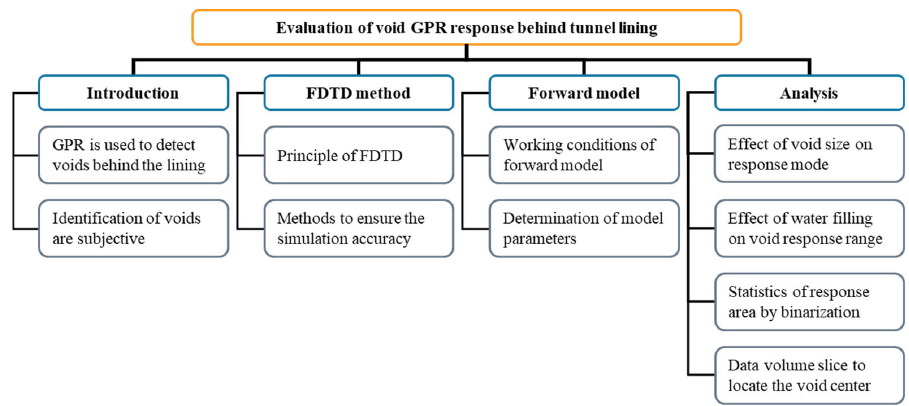
Figure 1. The research flowchart of this study including the research contents and